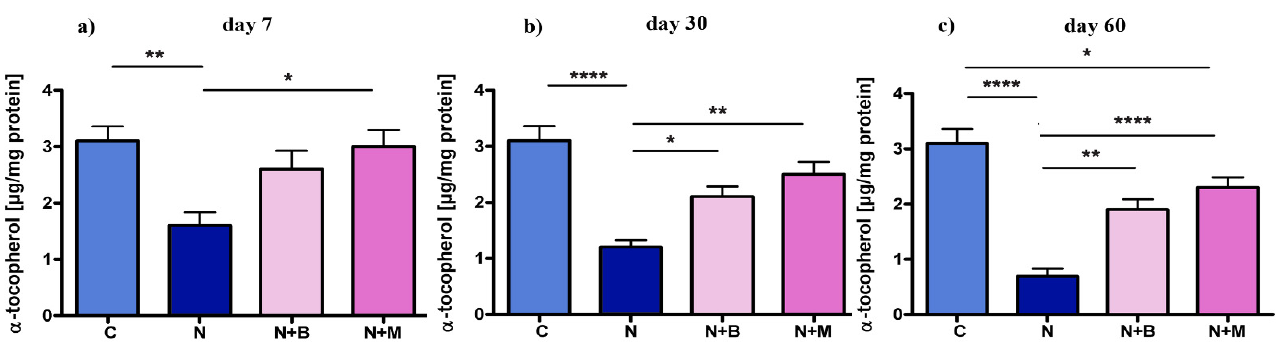
Figure 4. Content of α -T in EM under chronic acoustic stress conditions. Animals ( n = 6) were treated for 60 days with noise (N) or left untreated (C). Mesedin (M) and beditin (B) were injected daily i.p. to the rats exposed to chronic noise (N + M and N + B, respectively). One-way ANOVA with Sidak’s multiple comparison test, * p < 0.05, ** p < 0.01, **** p > 0.0001. The mean ± SEM values of EM content of α -T on days 7, 30, and 60 after exposure of noise and mesedin/beditin are shown in ( a ), ( b ), and ( c ) , respectively.